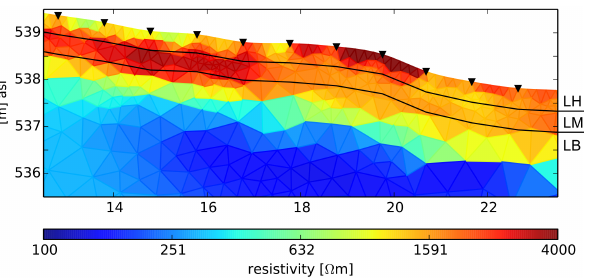
Figure 5. ERT section of profile A with plotted layer boundaries (date: 21 October 2008).